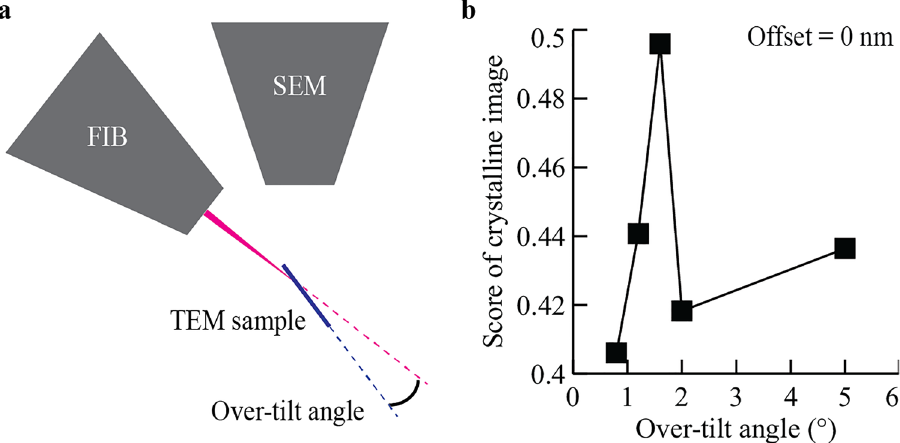
Figure 2. Optimizing FIB parameters for Si. ( a ) A side-view diagram of the over-tilt angle, which is the angle between the plane of the TEM sample and the ion beam. ( b ) A plot of the score of the crystalline image as a function of the over-tilt angle used for the 2 kV-FIB polishing step. We prepared five lamellae, using over-tilt angles of 0.8°, 1.2°, 1.6°, 2.0°, and 5.0°, respectively. For each lamella, the score of the crystalline image was calculated from the high-resolution STEM images (see “Methods” section and Supplementary Fig.